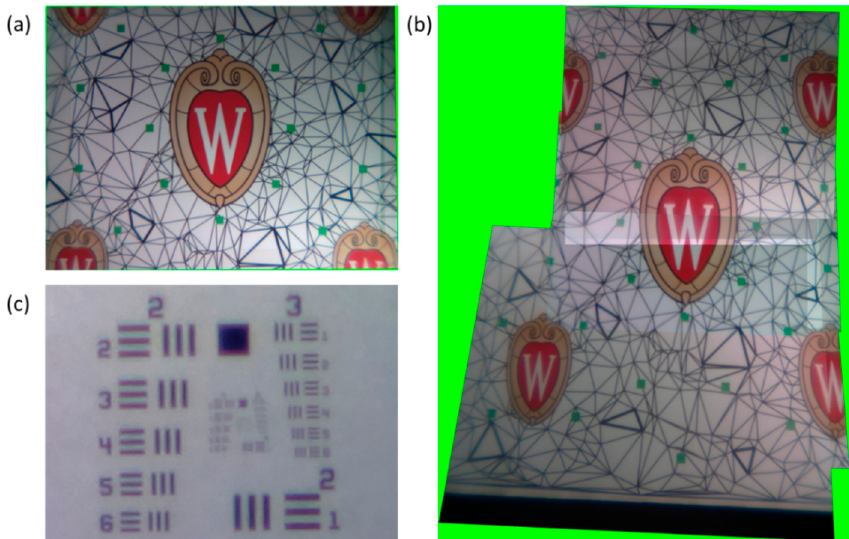
Figure 8. ( a ) A stitched image composed of nine separate images from the central 3 × 3 section of the array while the flexible sheet is on a flat surface. When on a flat surface the system has an FOV of 21.5 ◦ . ( b ) A stitched image composed from images obtained from the same central 3 × 3 section of the array, only now wrapped around a curved surface (radius equal to 70 mm). The FOV is increased significantly in the direction of curvature, up to 40.4 ◦ . ( c ) An image of a 1951-USAF resolution target obtained from one of the lenses in the array. Smallest resolvable line pair is group 3, element 6, corresponding to 14.25-line pairs / mm, or an angular resolution of 0.7 mrad. Similar results were obtained for other lenses in the array.